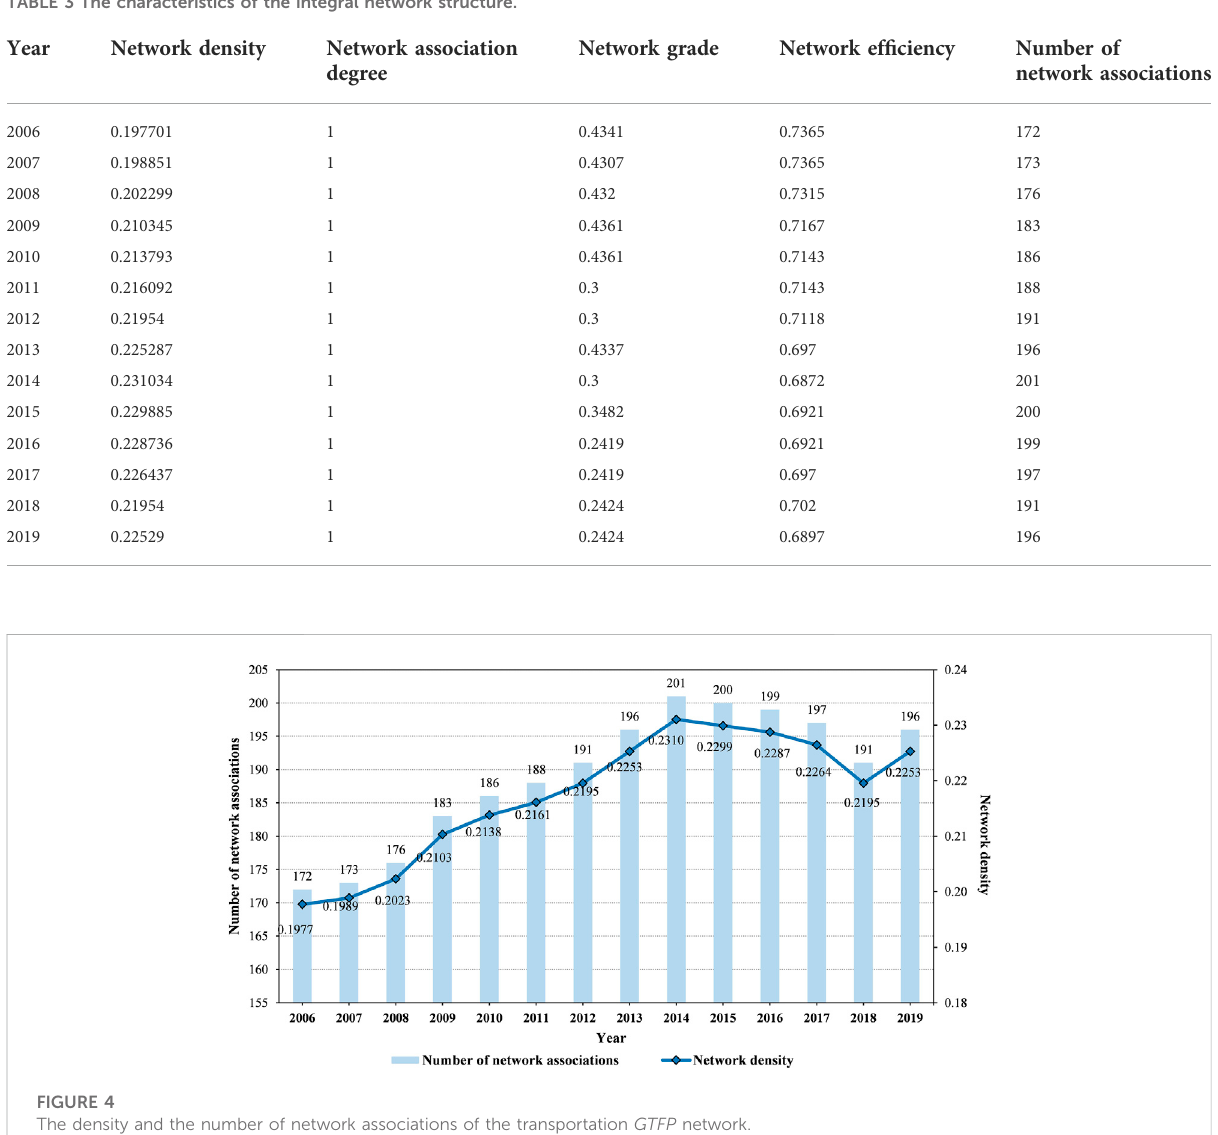
TABLE 3 The characteristics of the integral network structure.